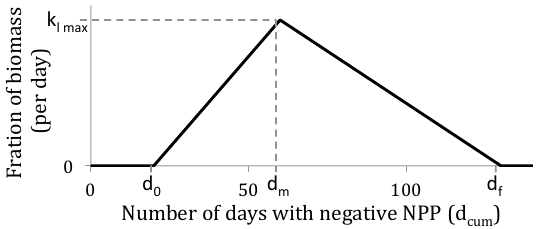
Figure 1. Additional non-vascular biomass loss turnover rate ( k l in d − 1 ) during the non-growing season period when NPP is lower than or equal to zero, starting at 0 on the horizontal